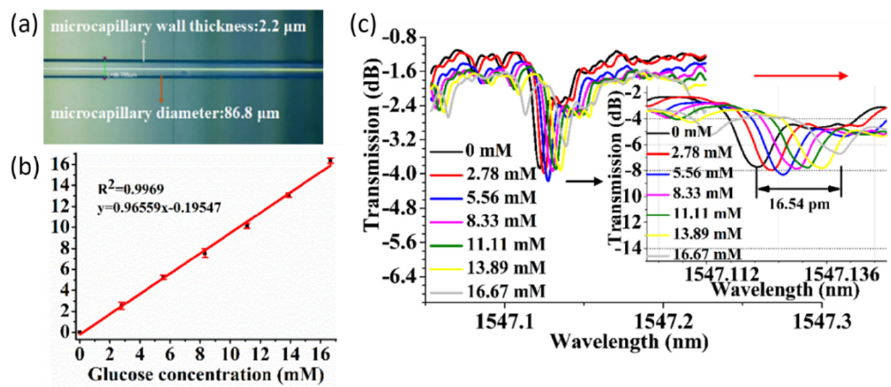
Figure 29. ( a ) Microscope image of the microcapillary resonator. ( b ) linear fitting for glucose concentration test performed in ( c ). ( c ) Measurement results for glucose detection. Reproduced from ref. [141] with permission © The Optical Society of America.